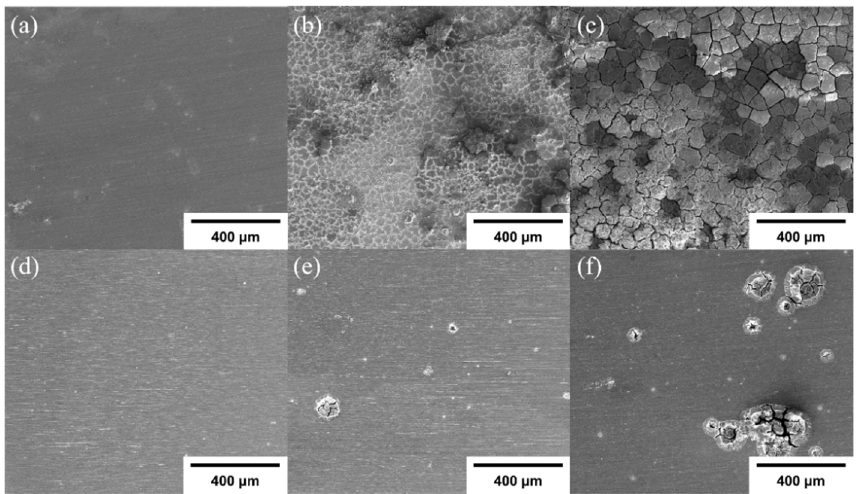
Figure 8. SEM images of the uncorroded surfaces of ( a ) bare Mg–Ca alloy and ( d ) HZO(200 cycles)/Mg–Ca. The corroded surfaces of bare Mg–Ca alloy immersed in SBF solution for ( b ) 8 h, and ( c ) 16 h and the corroded surfaces of HZO(200 cycles)/Mg–Ca immersed in SBF solution for ( e ) 8 h, and ( f ) 16 h.